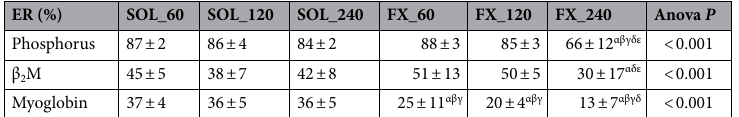
Table 3. Extraction ratios for phosphorus, β 2 M and Myoglobin in the six dialysis test sessions ( n = 10). β 2 M: beta-2-microglobulin; SOL: Solacea; FX: FX800 CorDiax; _60: dialysis of 60 min; _120: dialysis of 120 min; _240: dialysis of 240 min. α P < 0.05 versus SOL_60; β P < 0.05 versus SOL_120; γ P < 0.05 versus SOL_240; δ